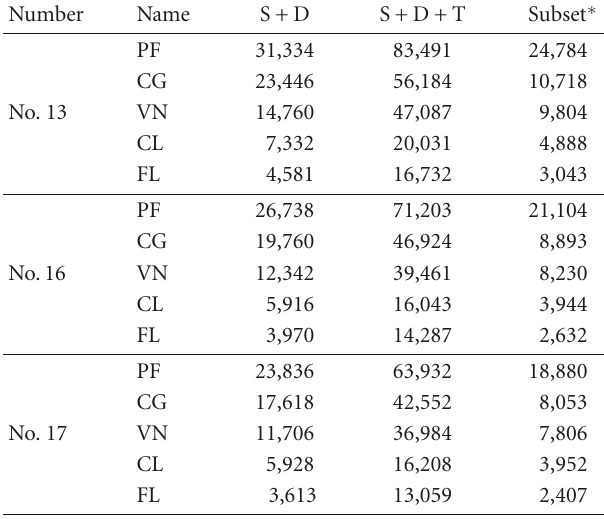
∗ Template used in Experiment